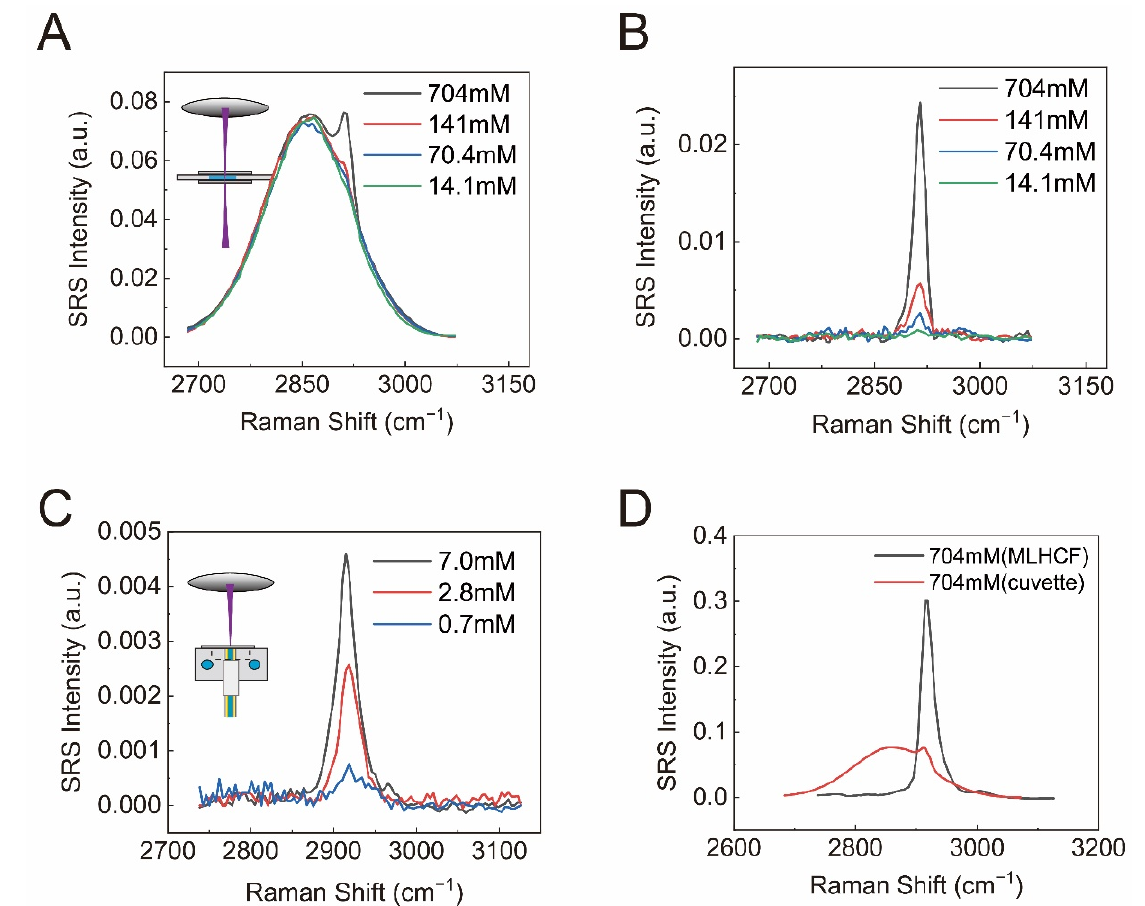
Figure 4. ( A ) Original SRS spectra of DMSO/water solutions in the cuvette with different concentrations; ( B ) background-corrected SRS spectra of DMSO/water solutions in the cuvette with different concentrations; ( C ) background-corrected SRS spectra (2915 cm − 1 ) of DMSO with different concentrations via MLHCF with a length of 8.3 cm; ( D ) SRS spectra of 704 mM DMSO from the cuvette and the 8.3 cm